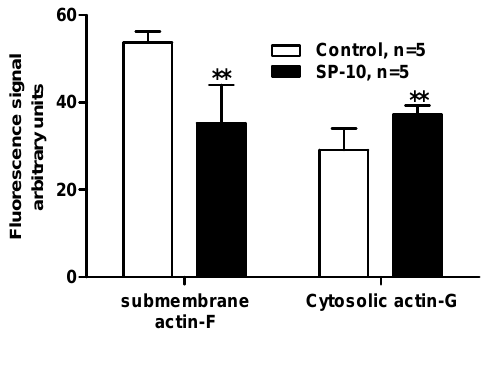
Figure 10. Submembrane F-actin and cytosolic G-actin quantification. The quantification was performed using NIG ImageJ software on five representative cells of each group, control and SP-10-treated, as numbered on Figure 9 panel C. Results are presented as means ± SD (n = 5 for each group). (** p < 0.01 versus control group,